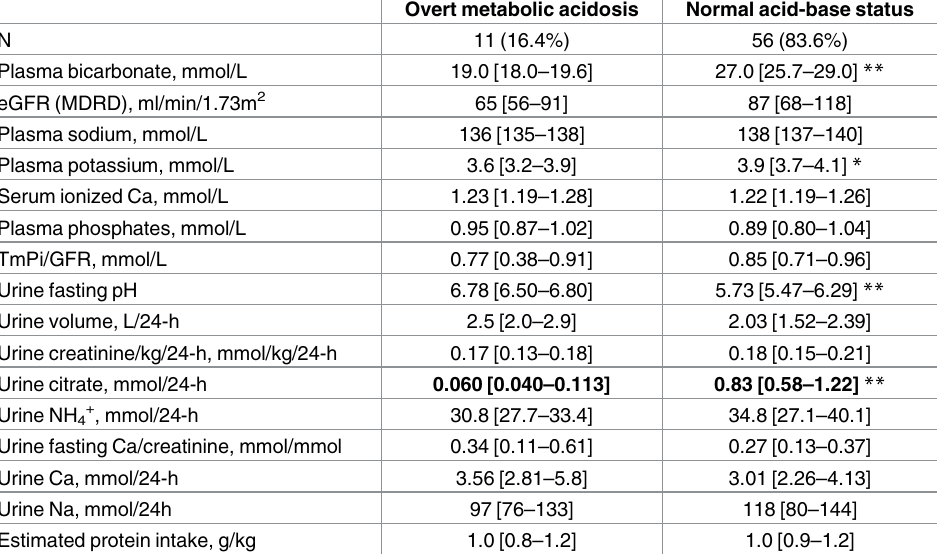
Table 2. Biological characteristics of the 67